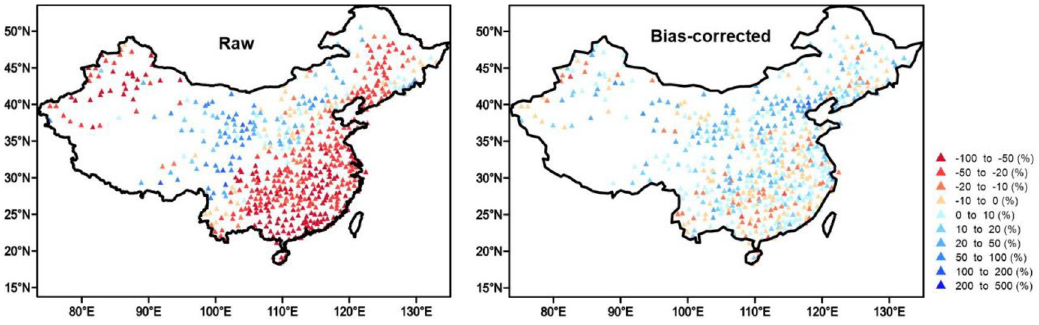
Fig 3. The spatial pattern of bias for climatology of annual maximum precipitation in the raw ensemble and the bias- corrected ensemble relative to observation during current climate conditions. (Made with Natural Earth. Free vector and raster map data @